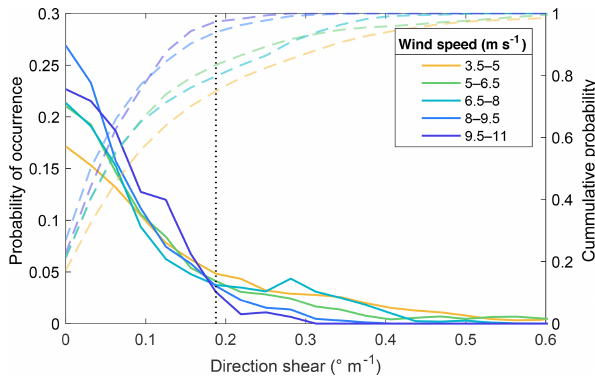
Figure 11. Directional wind shear probability density (solid lines) and cumulative (dashed lines) distributions for 1.5ms − 1 wind speed regimes. The black dotted line marks 0.1875 ◦ m − 1 of direc- tional wind shear.